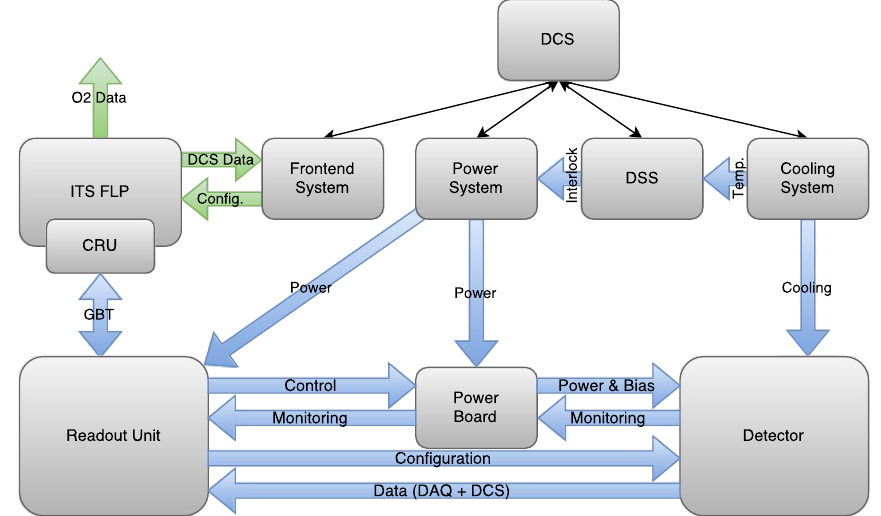
Figure 2. Schematic representation of the Detector Control System (DCS) for the Inner Tracker System (ITS)